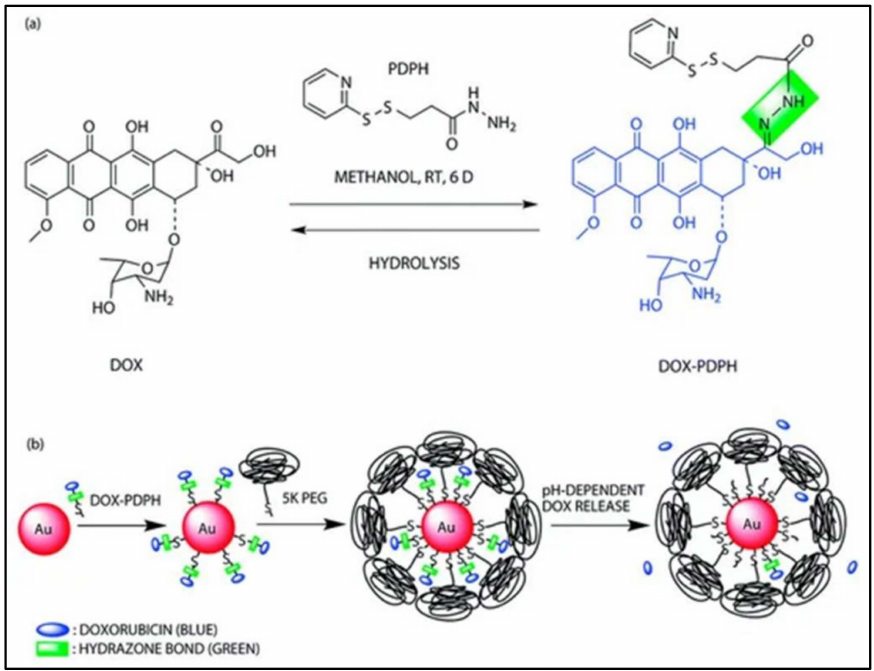
Figure 11. A pH-sensitive drug-gold nanoparticle system: ( a ) chemical synthesis of the doxorubicin– hydrazone linker conjugate (dox–PDPH); ( b ) schematic illustration of the synthesis of the multifunc- tional drug delivery system and its pH-dependent doxorubicin release